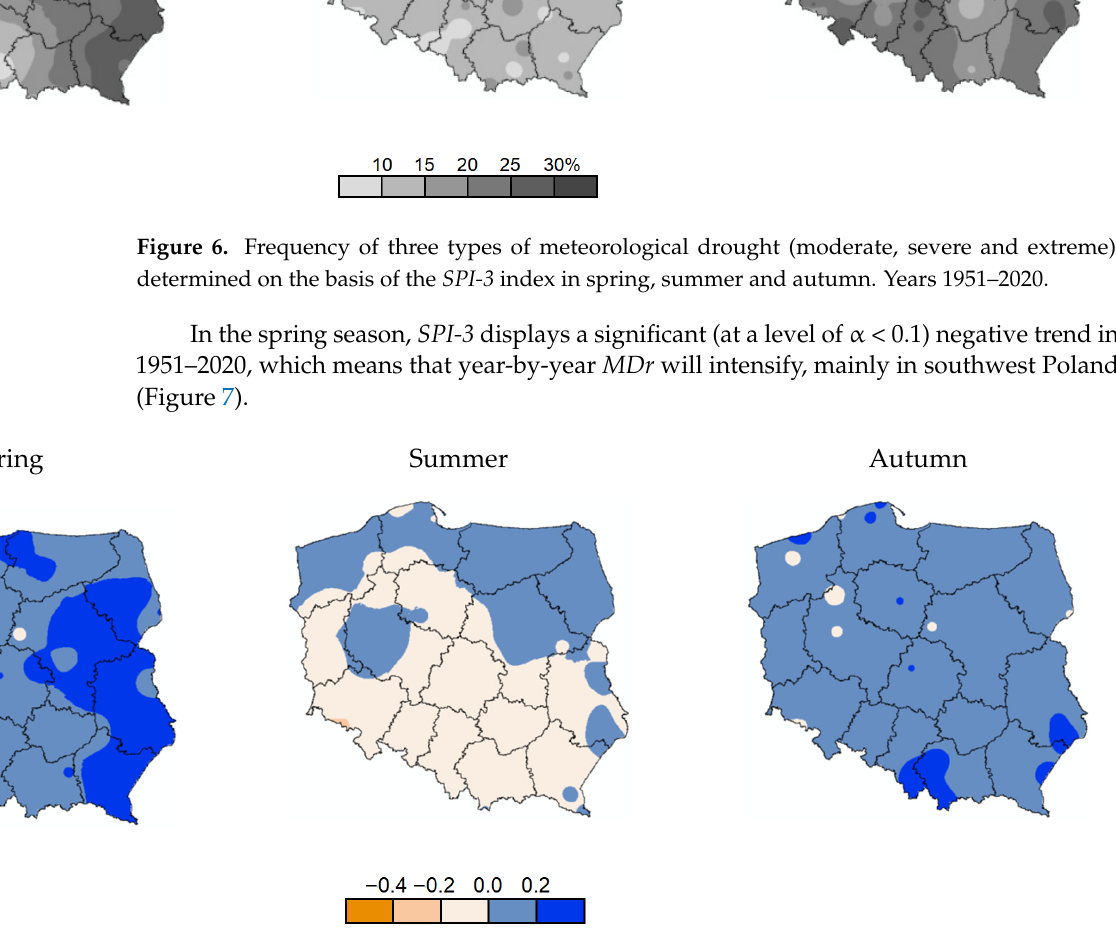
Figure 7. Correlation coefficient calculated for the linear trend of SPI-3 in spring, summer and autumn. Years 1951–2020.